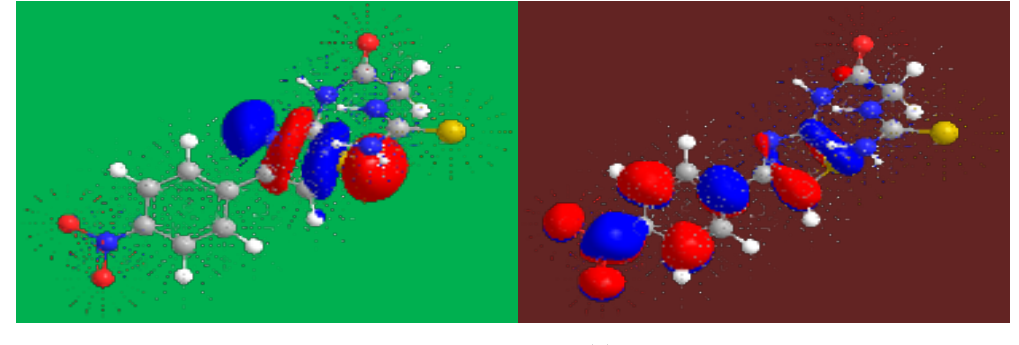
Figure 1. Highest occupied molecular orbital (HOMO) and the lowest unoccupied molecular orbital (LUMO) for compounds (2–8).